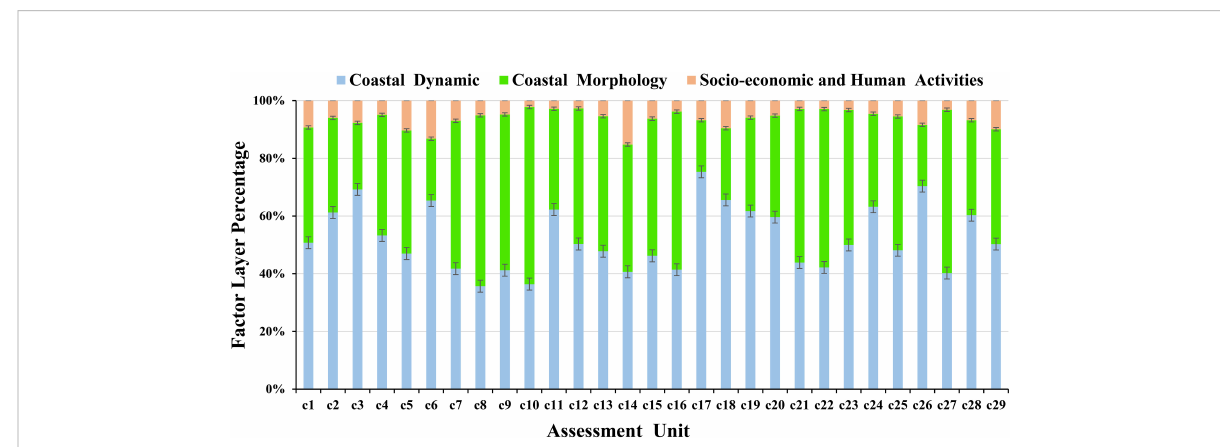
FIGURE 9 Map of the proportion of coastal morphology, coastal dynamics, and socioeconomic and human activity factors in each assessment